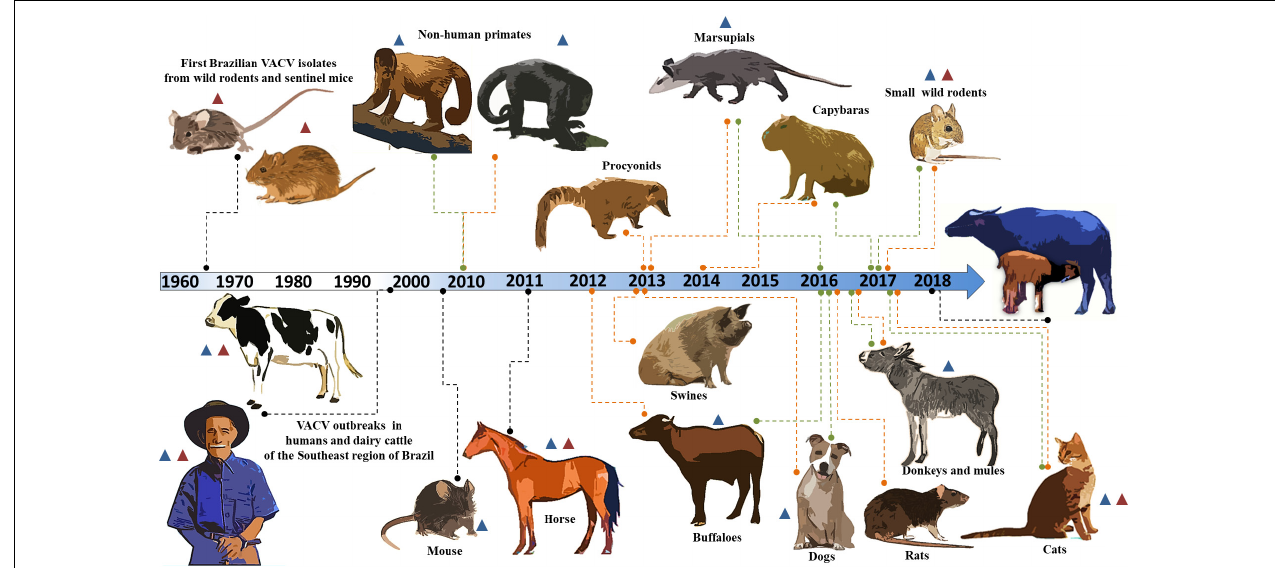
FIGURE 1 | Timeline of identification of the host range of the Brazilian vaccinia virus. A timeline of Brazilian VACV circulation is shown. The orange and green lines indicate serological and molecular evidence, respectively. The black lines indicate viral isolation. The blue and red triangles represent circulation of the VACV GI (group I) and VACV GII (group II), respectively. The years for each study are indicated along the timeline.